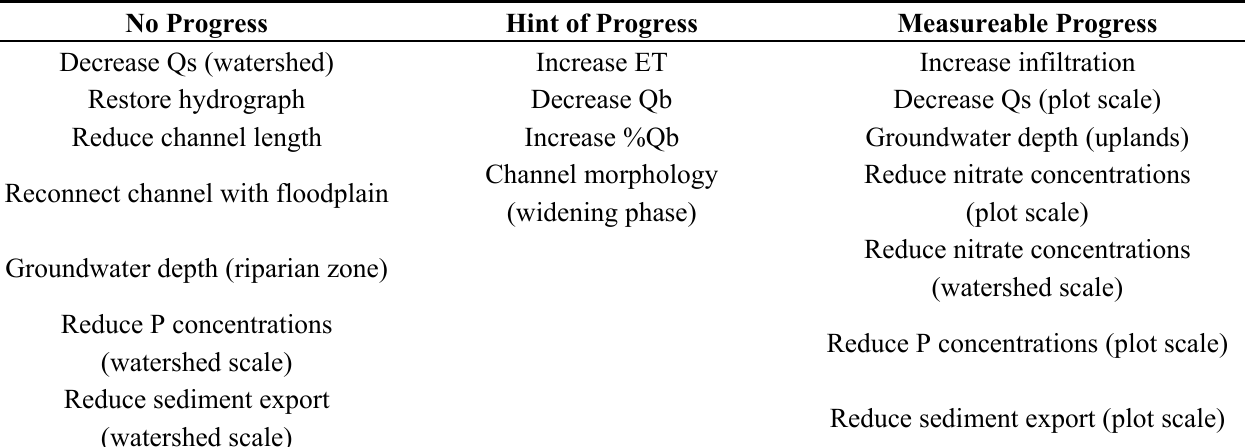
Table 3. Degree of progress being made toward restoration of key hydrologic processes at the Neal Smith National Wildlife Refuge